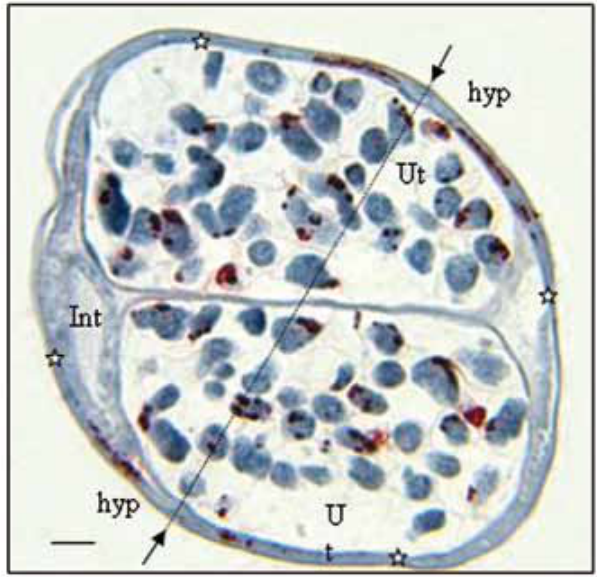
Fig. 1. – visualization of Wolbachia in filaria by immunostaining. transverse distal section of female Litomosoides sigmodontis , labora- tory strain, showing two uteri with divided eggs, stained with a rabbit polyclonal antiserum against Wolbachia Surface Protein (WSP) of B. pahangi Wolbachia (Wol-Bp-WSP, dilution 1:2000, Streptavidin- HrP, aeC; hematoxylin counterstaining). Wolbachia (red spots) are observed in uterine contents (eggs) and in hypodermis (int, intestine; Ut, Uterus; black arrows and dot line represent the lateral plan; hyp, hypodermis delineated by white stars; Scale: bar = 25